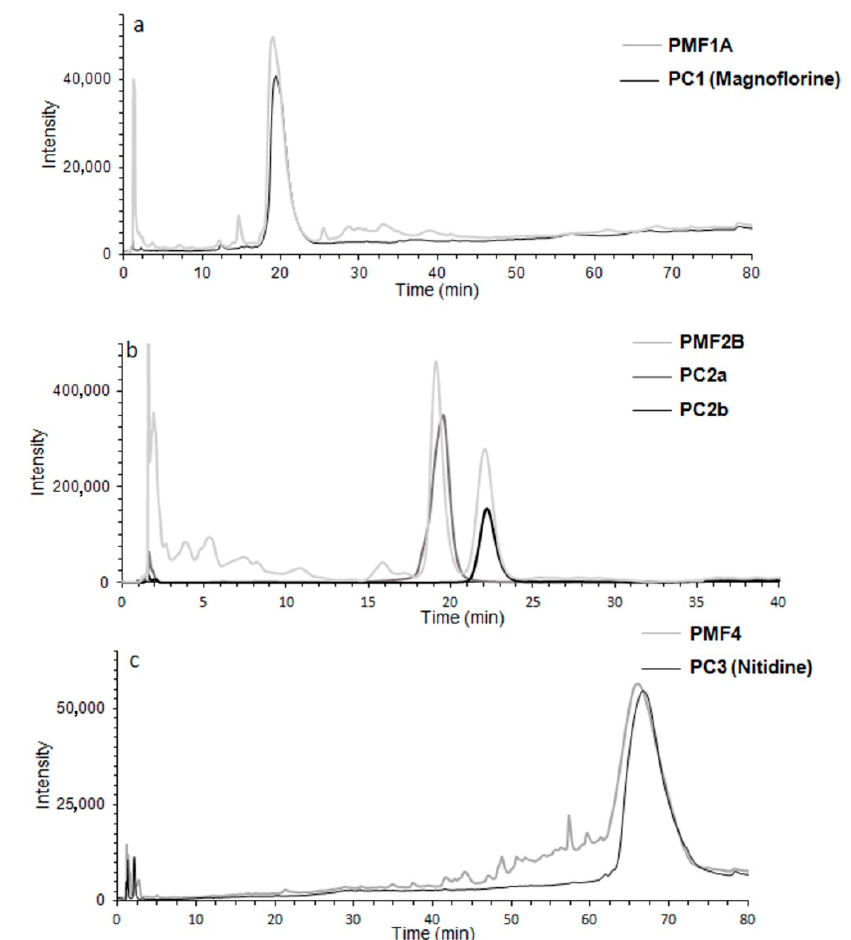
Figure 2. Chromatographic profiles of ( a ) PC1, ( b ) PC2a and PC2b and ( c ) PC3. The chromatographic profile of each isolated phytocomponents is overlaid with that of the PM fraction from which it was isolated, i.e., PMF1, PMF2 and PMF4, respectively.